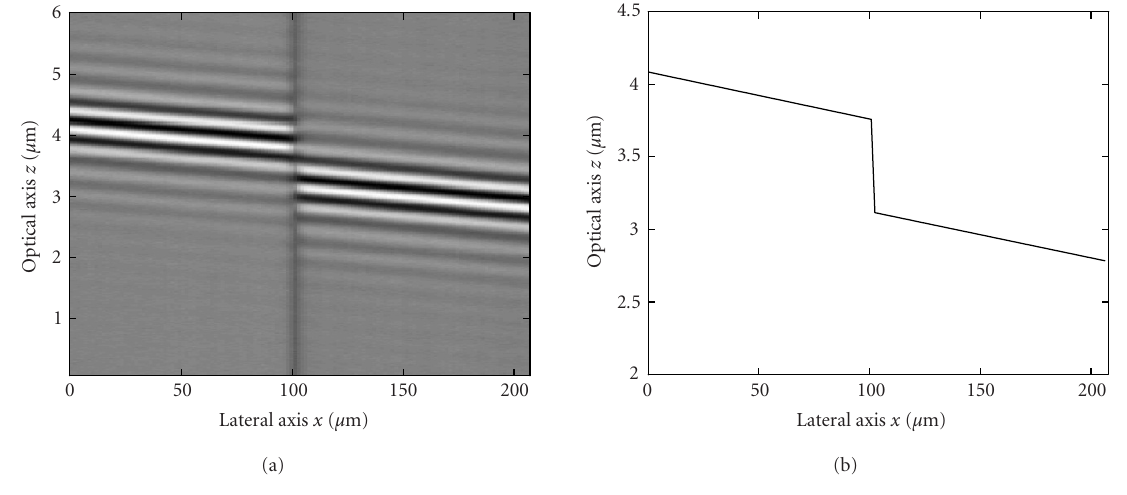
Figure 2: (a) An xz image of the sloping step and (b) reference